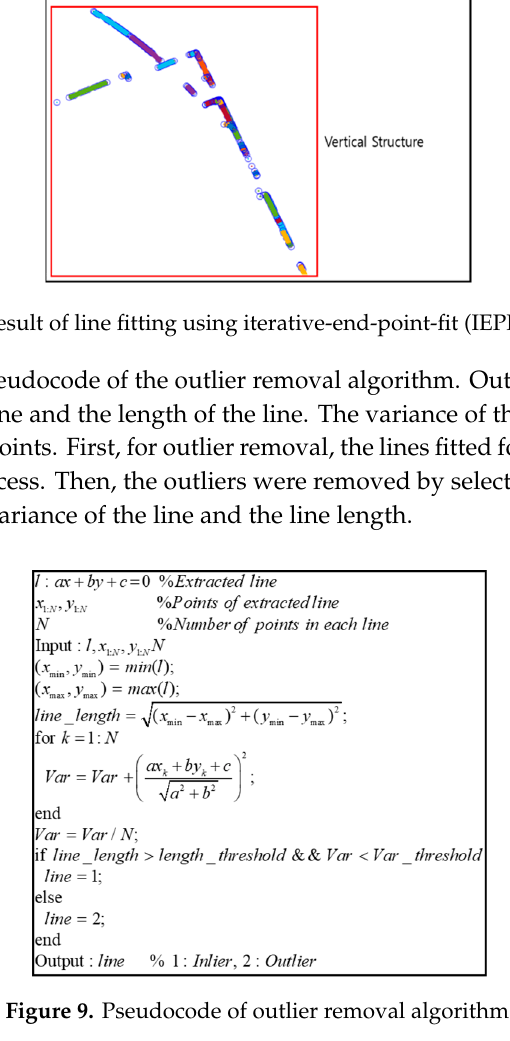
Figure 9. Pseudocode of outlier removal algorithm.